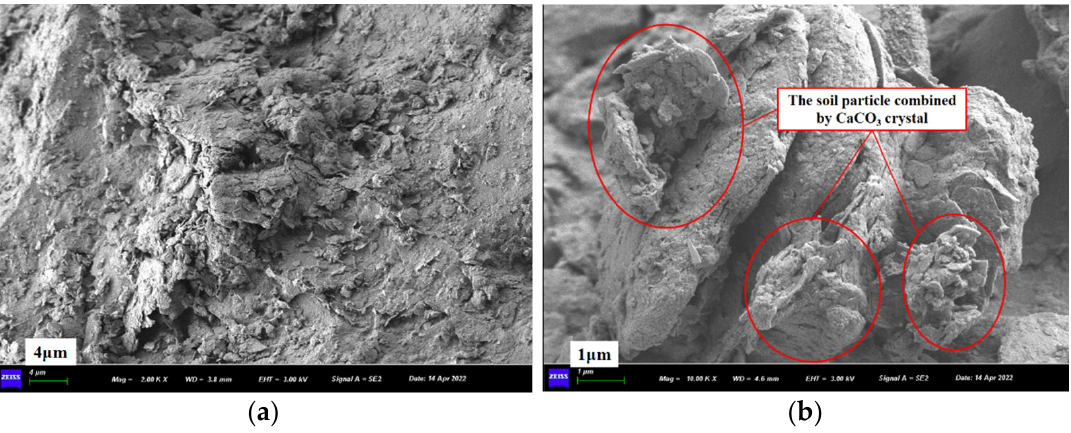
Figure 12. FESEM imagines of ( a ) pure CLS and ( b ) PMMRS.